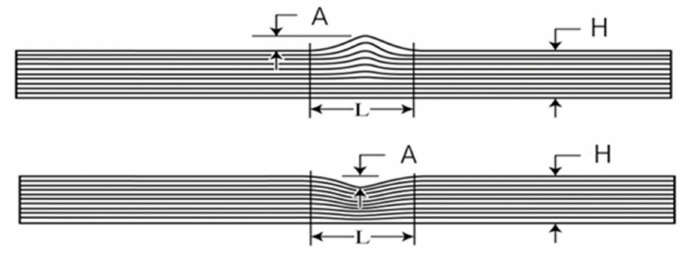
Figure 3. Side-view of specimens containing a fiber waviness defect.